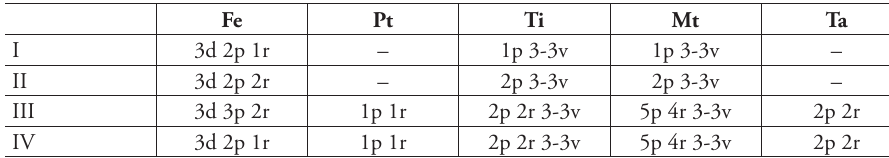
Type material. Holotype ♂ (ZMMU): Tajikstan, Khatlon Area, Dangara Distr., San- glogh (=Sanglok) Mt. Range above Shar-Shar Pass, 38°17'56"N, 69°13'36"E, 1700– 2060 m, 29.04.2015, (Y.M. Marusik). Paratypes: 3 ♂ (IZCAS), 2 ♂ (ZMMU), same data as